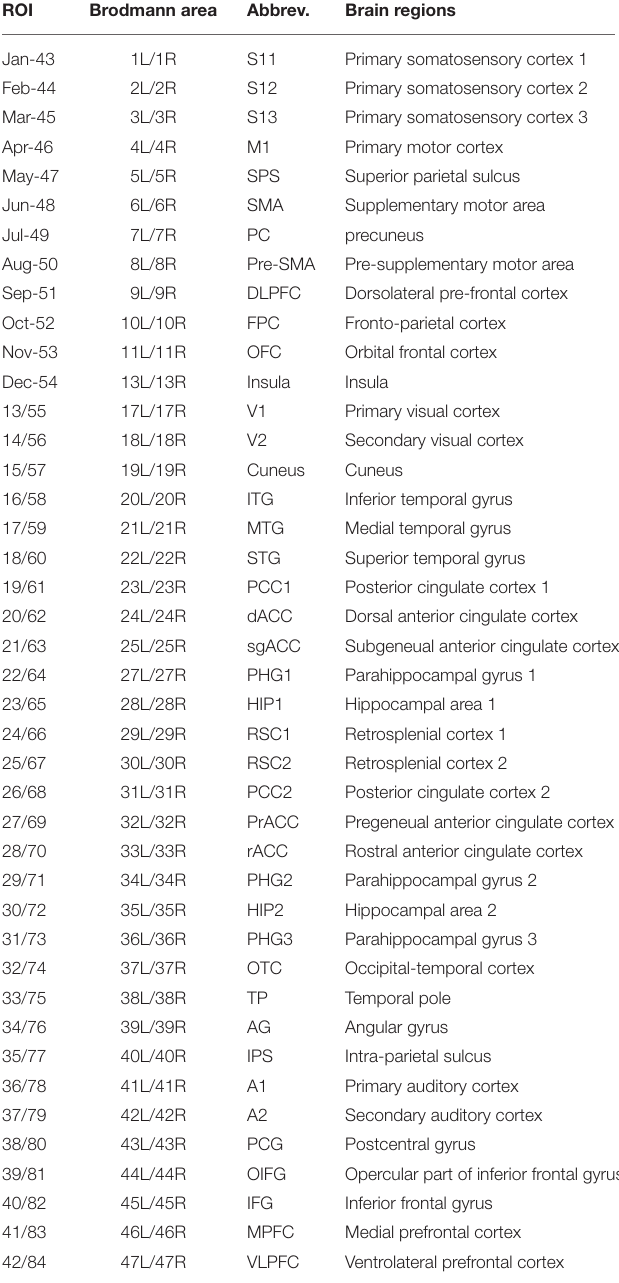
TABLE 1 | The 84 ROIs defined in the current study, which were exactly same as Jia and Yu (15). ROI Brodmann area Abbrev. Brain